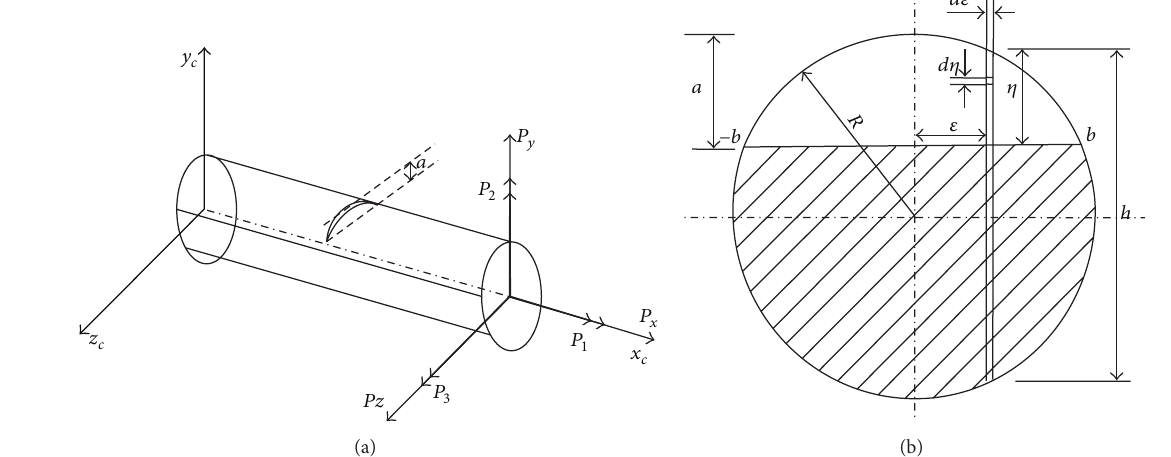
Figure 3: (a) A cracked shaft in general loading. (b) Cracked shaft cross